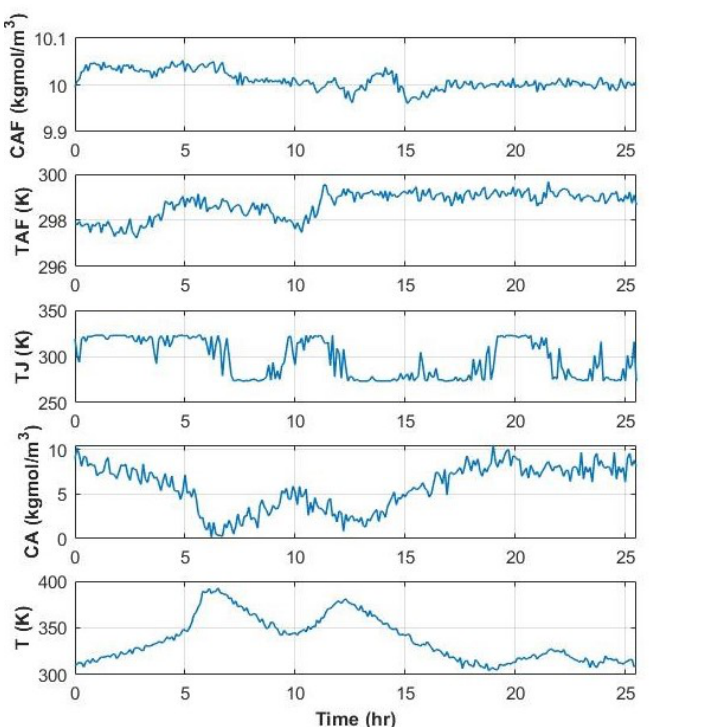
Figure 15. Training data inputs and outputs for the CSTR